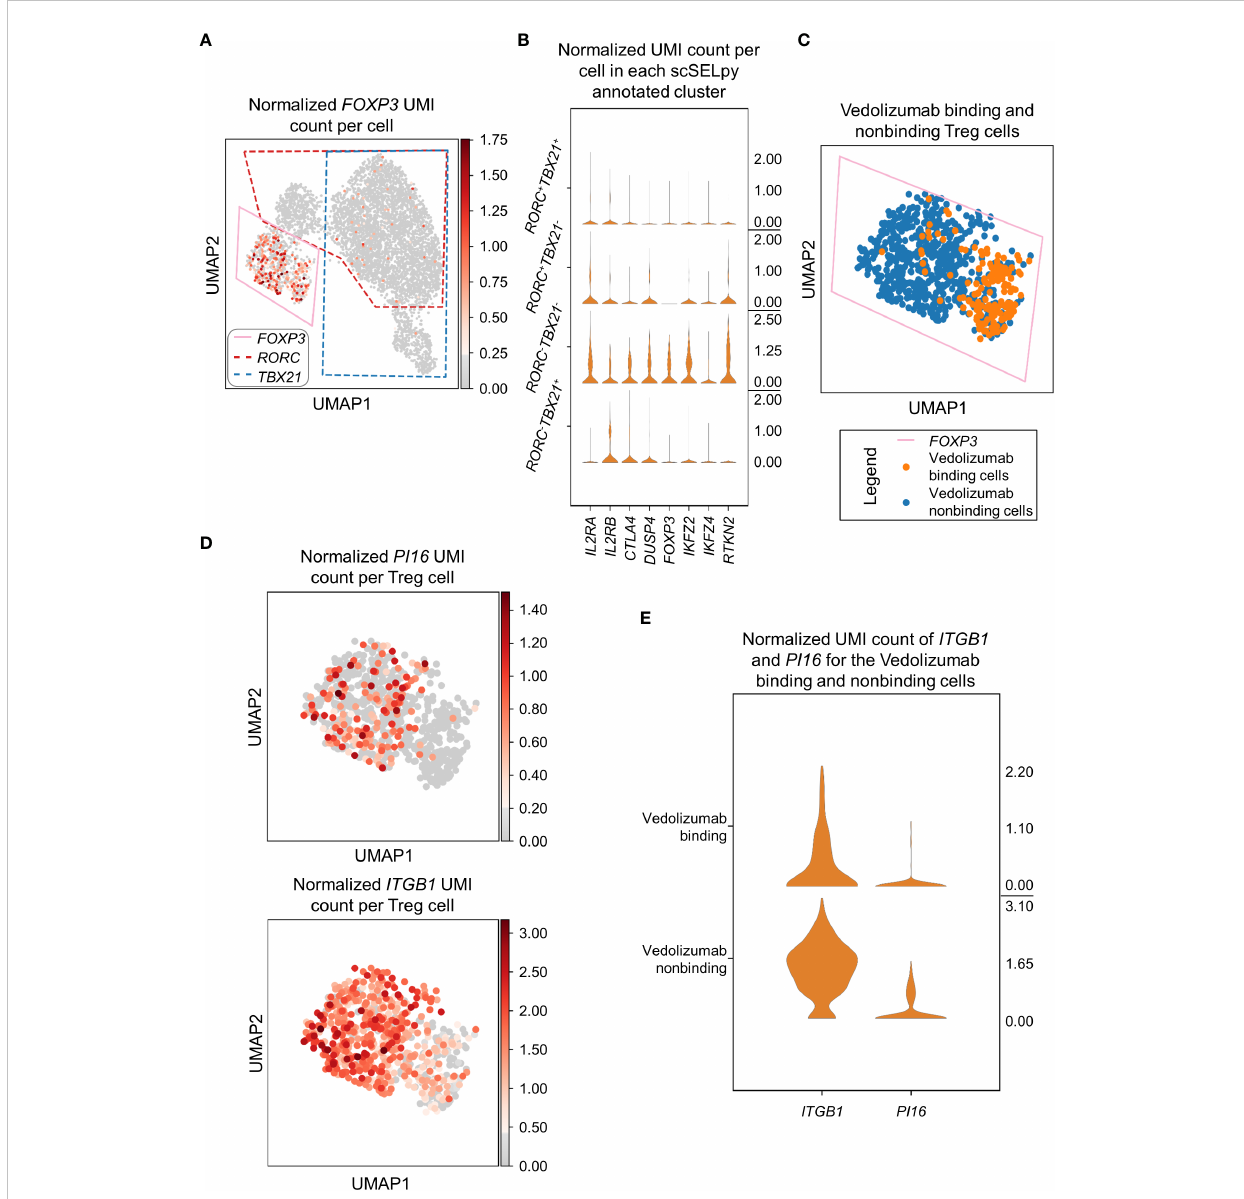
FIGURE 4 Selection and analysis of regulatory T cells with scSELpy. (A) Selection of the region enriched for FOXP3 expression, using the UMAP representation presented in Figure 2C. The selections for RORC and TBX21 from Figure 3A are marked with dotted lines. (B) Violin plots of the expression of eight genes associated with Tregs in the four regions determined based on TBX21 and RORC expression. (C) Depiction of cells binding vedolizumab or not as determined by FACS sorting prior to sequencing on the population selected in (A) . (D) Expression of ITGB1 and PI16 in the cell population selected in (A) . (E) Stacked violin plot of PI16 and ITGB1 expression for Vedolizumab-binding cells and cells that do not bind